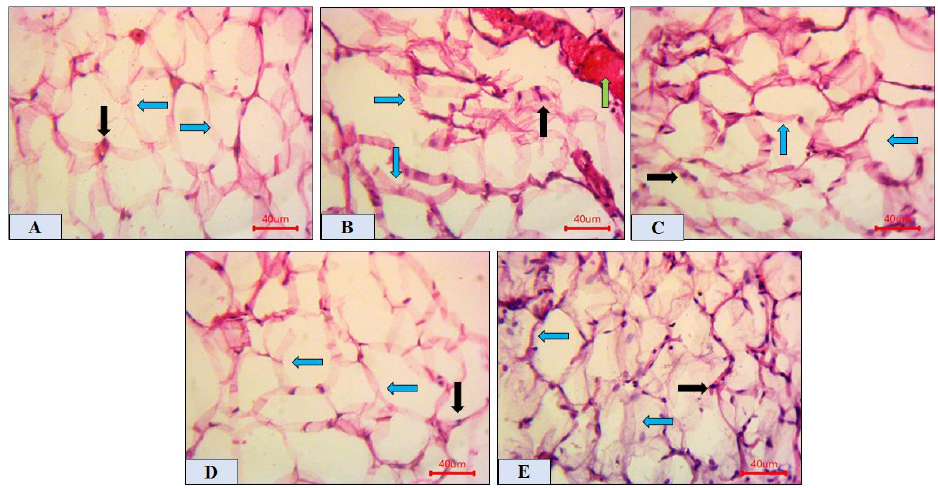
Figure 5. Photomicrographs of rat adipose tissue. ( A ) NC group showing normal polygonal fat cells (blue arrows) and normal adipose nuclei (black arrow). ( B ) Diabetic group showing large-sized, distorted adipocytes (blue arrows) with dilated, congested blood vessels (green arrows) and displaced adipose nuclei (black arrow). ( C ) DM + GB group showing improved adipose tissue (blue arrow) and normalized adipose nuclei (black arrow). ( D , E ) DM + TME (400 mg/kg) and DM + HSP (100 mg/kg) group showing apparently normal adipose tissue (blue arrows) and normalized adipose nuclei (black arrow), with a more prominent improvement in DM + TME. Scale bar = 40 µ m. NC, normal control; TME, total methanol extract; HSP, hesperidin; GB, glibenclamide; DM, diabe- tes mellitus.